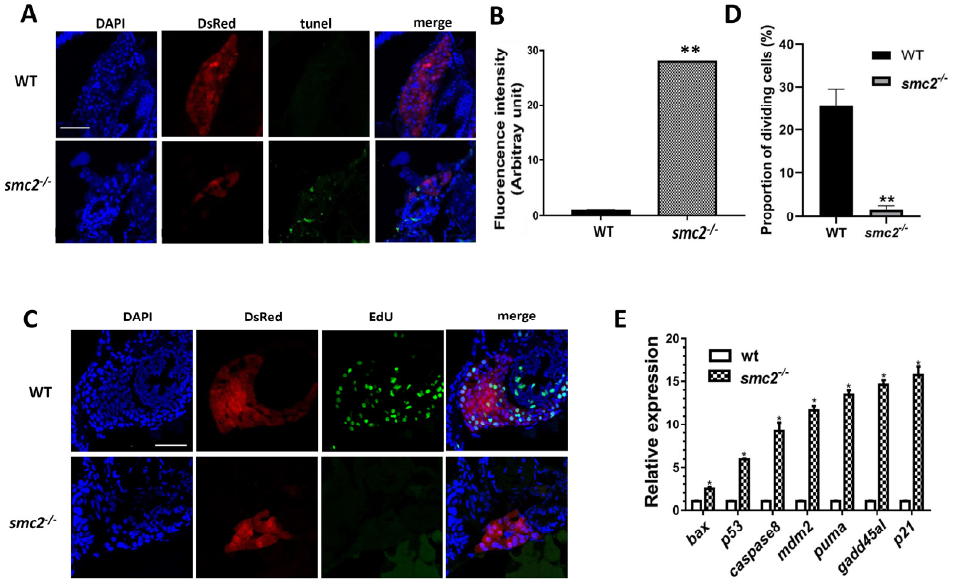
Figure 5. Hepatocellular apoptosis increased in SMC2 − / − mutants. ( A ) TUNEL analysis of apoptotic cells in the liver of WT and homozygous mutants under the Tg (fabp10a:dsRed; ela3l: EGFP) transgenic background at 96 hpf. Scale bar, 50 μ m. ( B ) Quantitative analysis of the apoptotic cells in the liver. Fluorescence intensities of three WT and three mutant embryos across the liver were determined using the ImageJ software. **, p < 0.01. ( C ) Frozen sections were stained with EdU staining buffer and nuclei counterstained with DAPI (blue) under the Tg (fabp10a:dsRed; ela3l: EGFP) transgenic background at 96 hpf. Scale bar, 50 μ m. ( D ) The proportions of EdU - positive cells vs. DAPI-positive cells in the liver of three WT and three SMC2 mutant embryos were determined using the ImageJ software. **, p < 0.01. ( E ) The mRNA levels of genes involved in apoptotic pathways were analyzed with qPCR. Expression levels were normalized to WT. The data expressed as mean ± SD were representatives of three independent experiments containing 40 embryos per sample. *, p < 0.01.